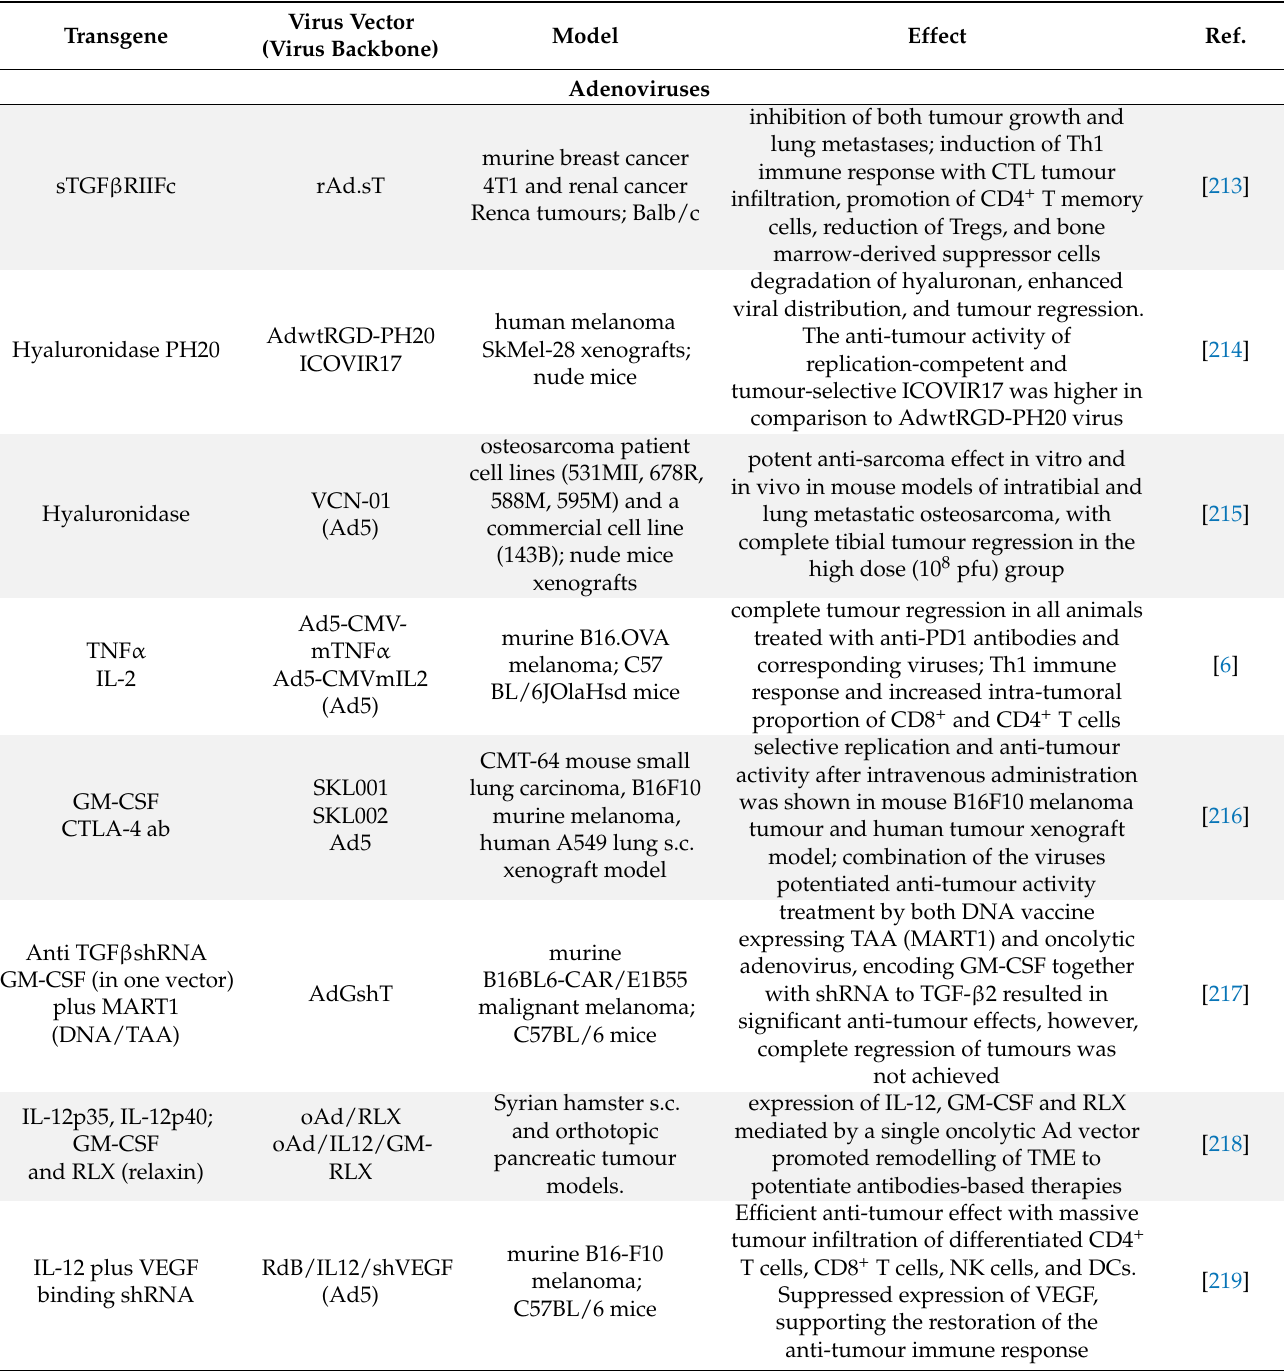
Table 4. Virus vectors encoding cytokines and other molecules for remodelling tumour stroma and multiple immune cell